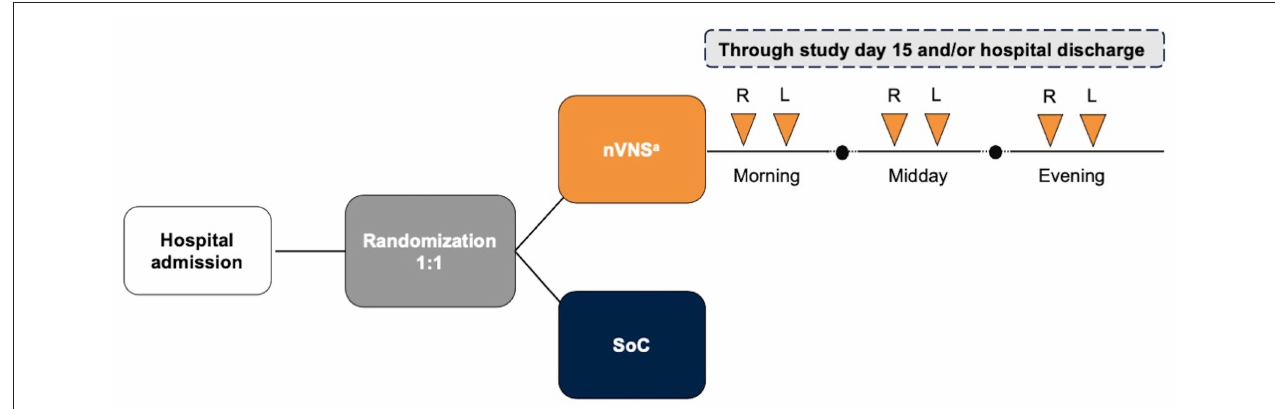
FIGURE 1 | Study Design. a Each stimulation was 2min in duration. L, left side; nVNS, non-invasive vagus nerve stimulation; R, right side; SoC, standard of care.